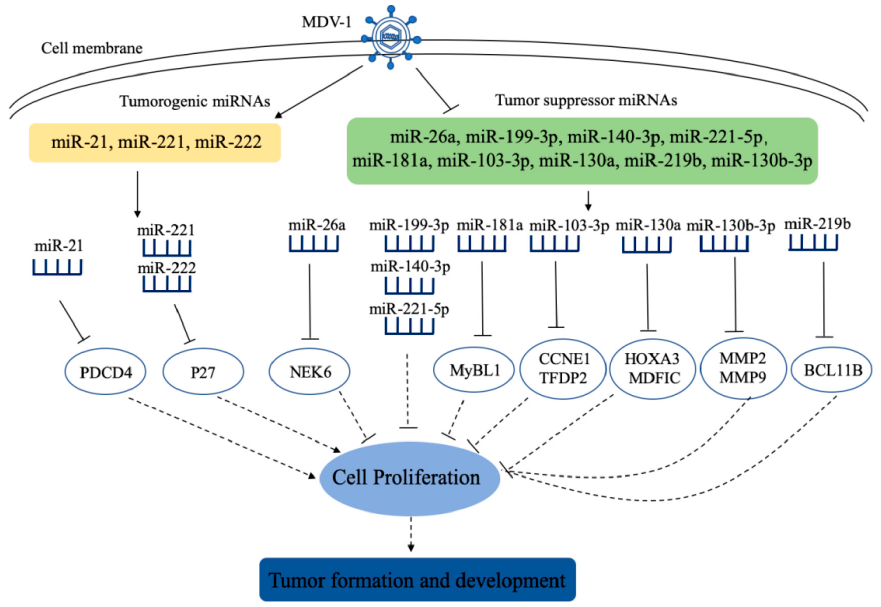
Figure 1. Schematic diagram of the roles of cellular miRNAs in the pathogenesis of Marek’s disease virus (MDV)-1 infection. After MDV-1 infects cells, the expressions of some cellular miRNAs are upregulated or downregulated, and they participate in MDV-1 induced tumors by targeting related